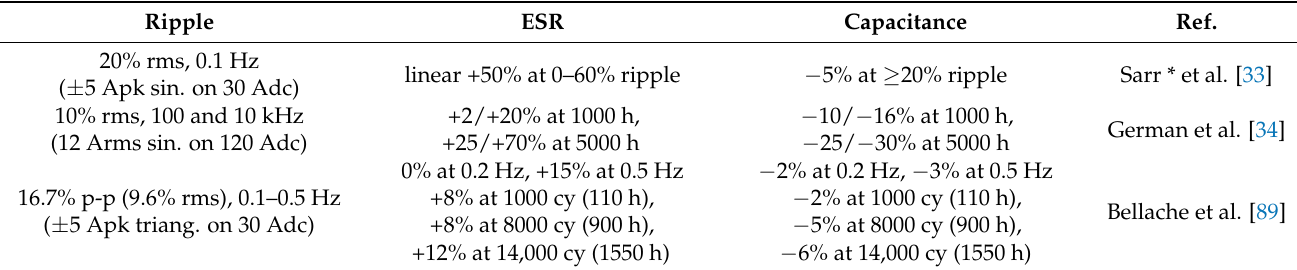
Table 2. Supercapacitors: dependency of ESR and capacitance on frequency, ripple, and number of cycles. Ripple ESR